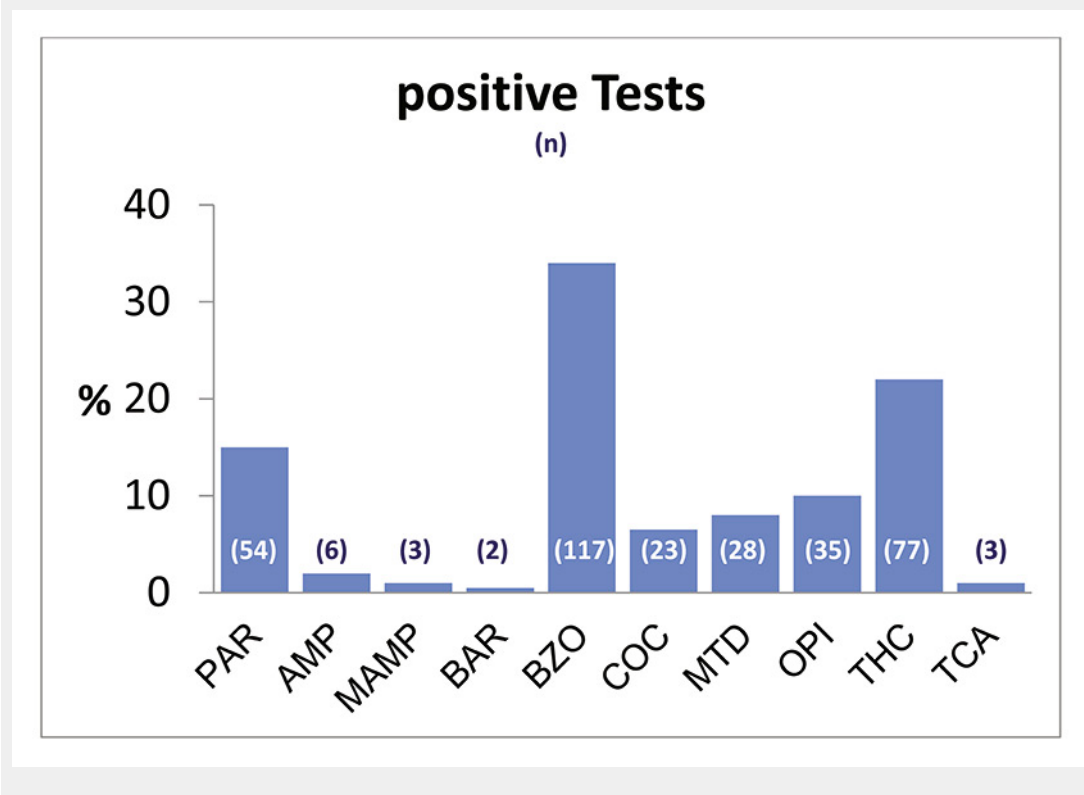
Figure 2 Spectrum of substances detected with the Triage ® TOX screen (204 positive urine samples with 348 substances detected). AMP = amphetamines; BAR = barbiturates; BZO = benzodiazepines; COC = cocaine; MAMP = metamphetamines; MTD = methadone; OPI = opiates; PAR = paracetamol; TCA = tricyclic antidepressants; THC =